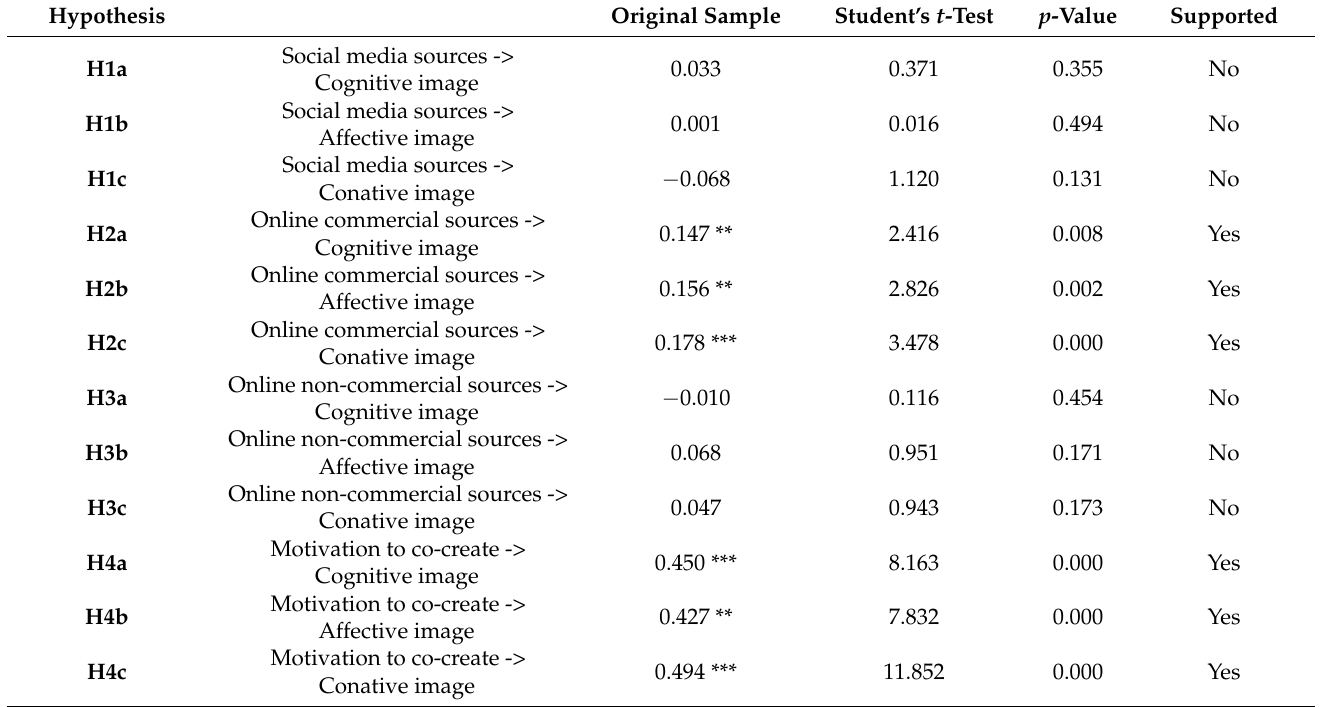
Table 6. Hypothesis validation